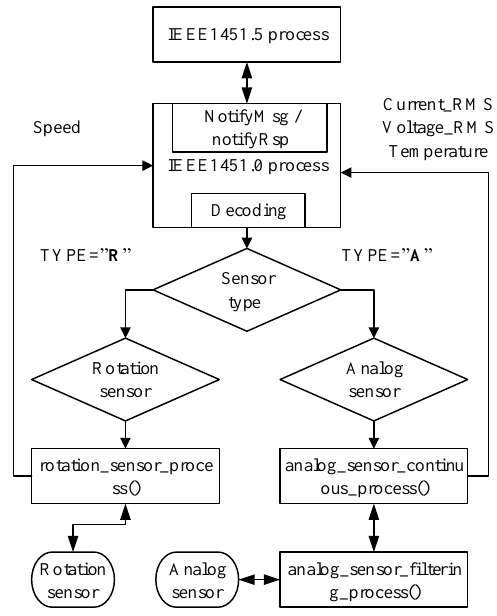
Figure 11. The structure of the implemented